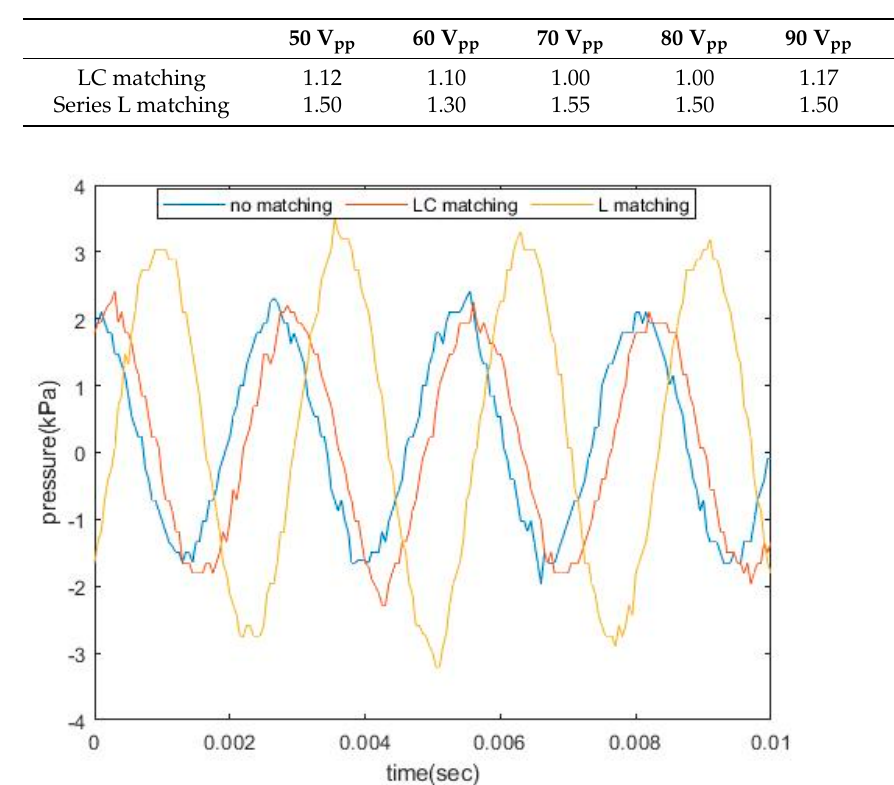
Figure 9. Acoustic pressure depending on matching conditions.